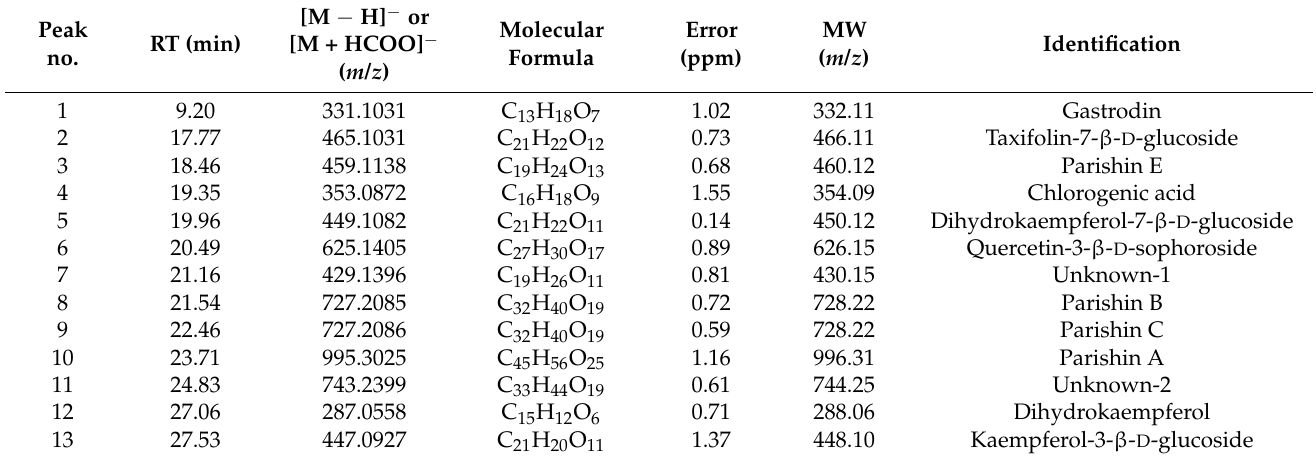
Table 1. Tentative identification of polyphenols in 70% MeOH extract of MT twig by HPLC-QTOF-MS.